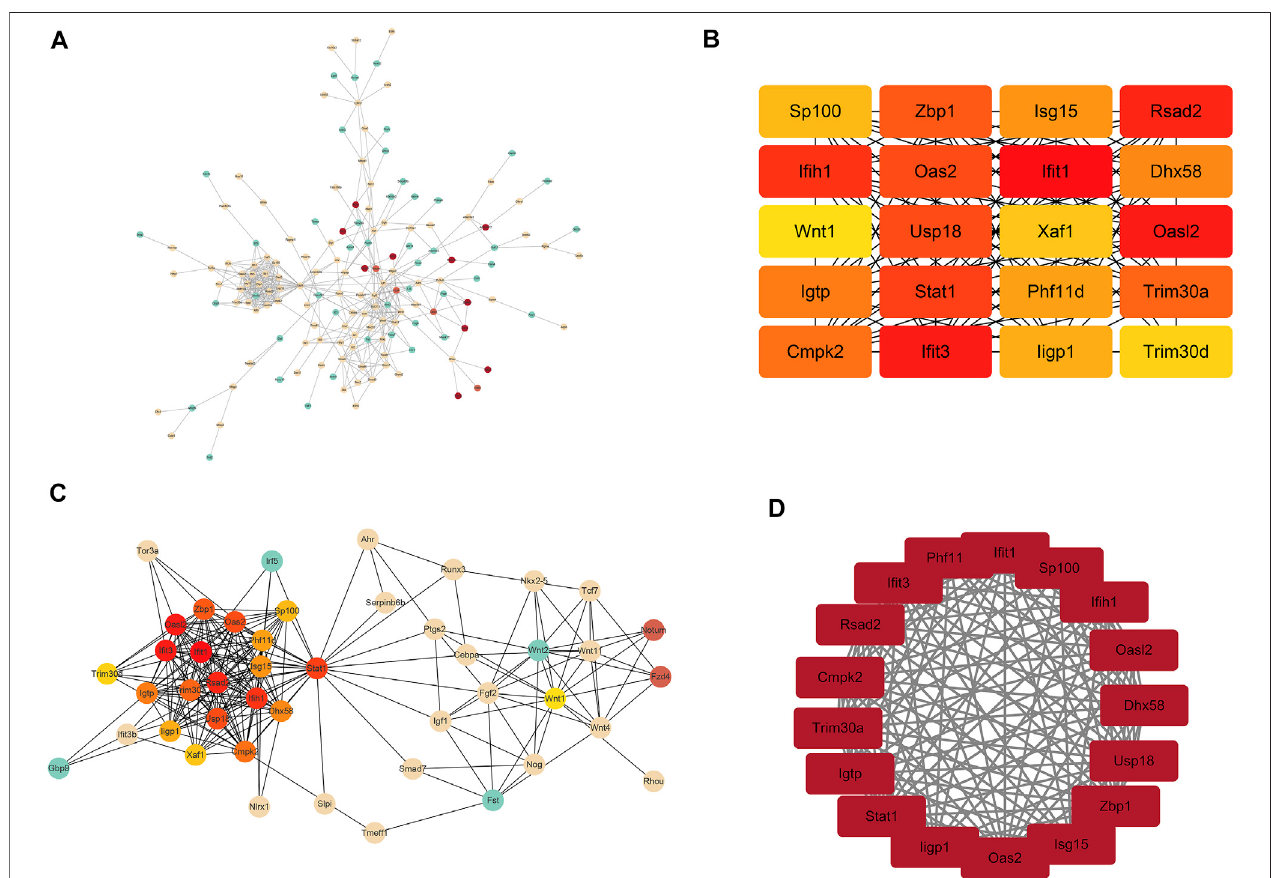
FIGURE 5 | Analysis results of PPI. (A) Total network interaction of all DEGs. The redder the color, the more important it is in the network relationship. (B) Top 20 hub genes in the interaction network. (C) Total network interaction of the top 20 hub genes and the differential genes that are directly related to them. (D) Top dense regions of the interactive density region in the PPI